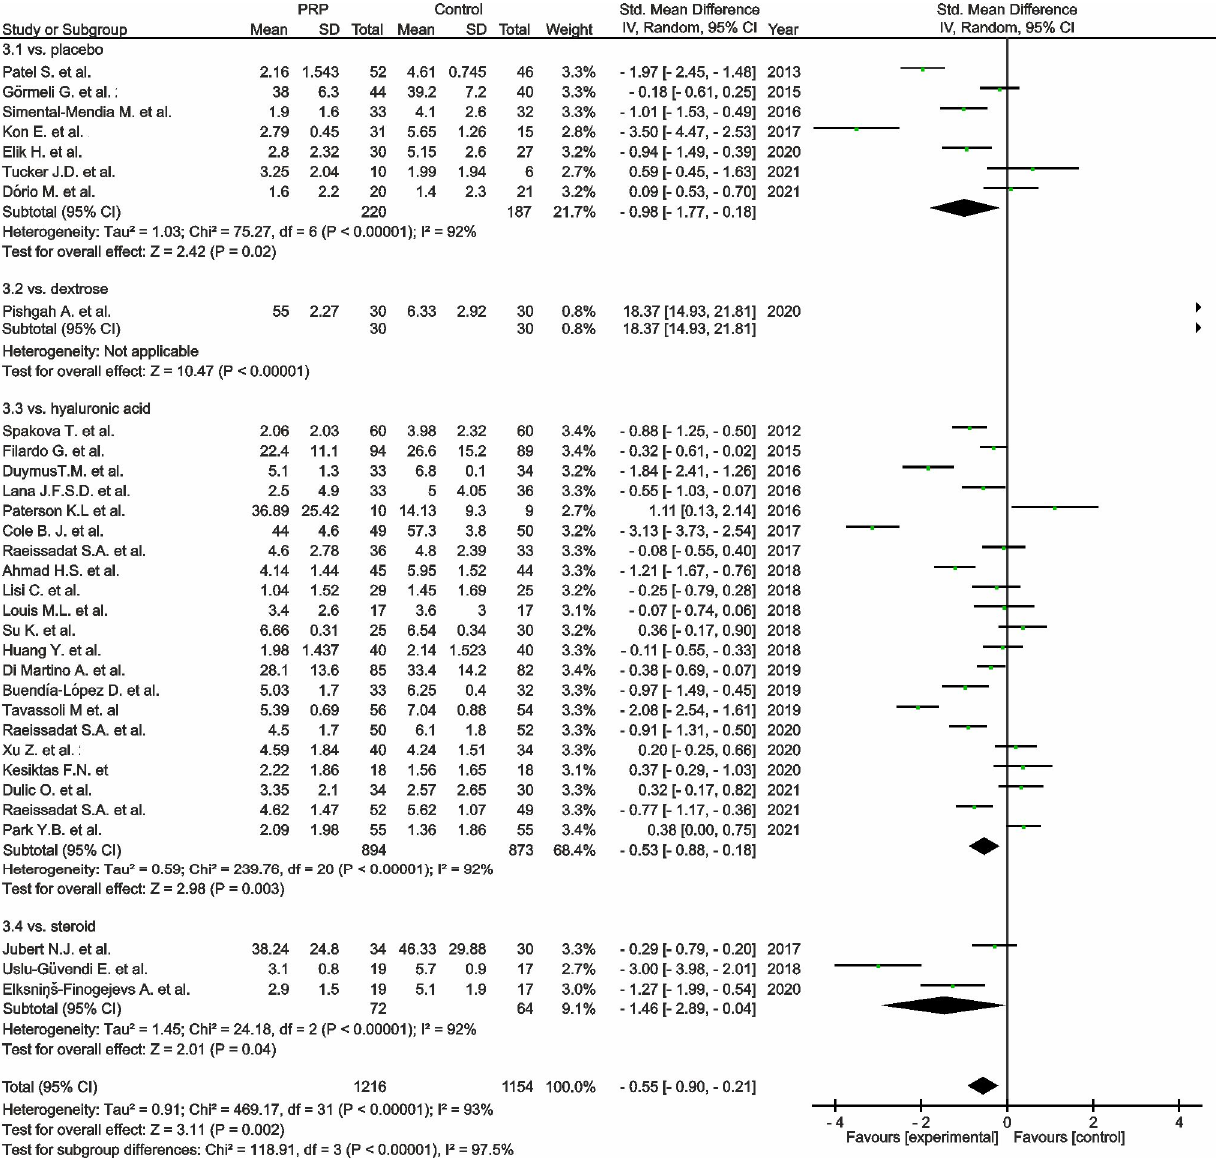
Figure 6. Forest plot for KOOS sub-scores (ADL, activities of daily living; CI, confidence interval; Figure 3. Forest plot for VAS scores comparing PRP versus control (CI, confidence interval; IV, in- Figure 3. Forest plot for VAS scores comparing PRP versus control (CI, confidence interval; IV, inverse IV, inverse variance; QoL, quality of life; SD, standard deviation; , mean with 95% confidence Figure 3. Forest plot for VAS scores comparing PRP versus control (CI, confidence interval; IV, in- verse variance; SD, standard deviation; , mean with 95% confidence interval for total and sub- interval for total and subtotals; , mean with 95% confidence interval for source data ). variance; SD, standard deviation; , mean with 95% confidence interval for total and subtotals; verse variance; SD, standard deviation; , mean with 95% confidence interval for total and sub- totals; , mean with 95% confidence interval for source data). mean with 95% confidence interval for source totals; , mean with 95% confidence interval for source data).